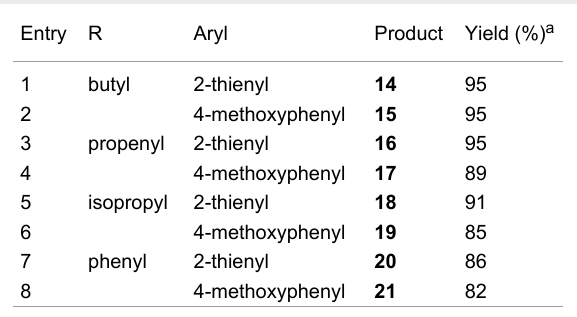
Table 4: Sonogashira cross-coupling reactions from alkynes 6–9